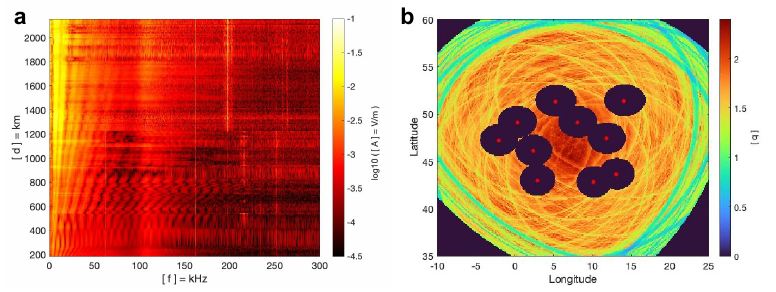
Figure 1. ( a ) Interpolated waveform bank spectrum (190–2150 km). ( b ) Sensitivity map using quality q value. The receivers are marked in red dots. The range is 35°N to 60°N for latitude and 10°W to 25°E for longitude with a pixel resolution of 0.5° ×